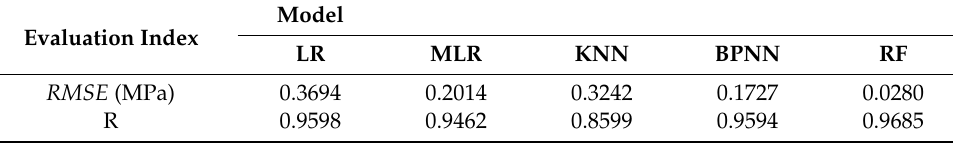
Figure 18. Taylor diagram of 5 models. Table 3. Evaluation of 5 ML models on UCS test